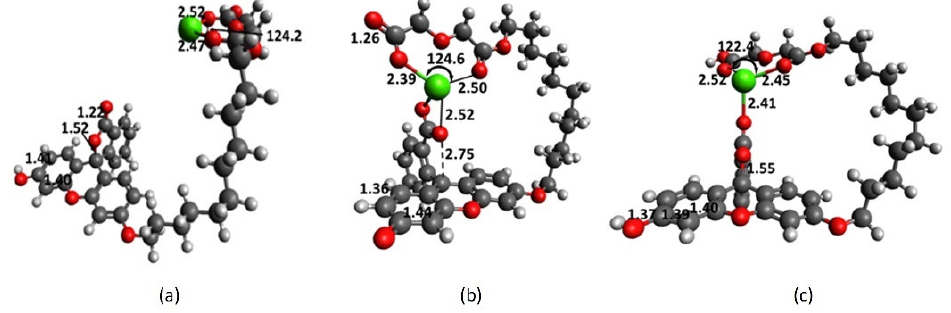
Figure 1. Complexes of 1 and 1a with Ca 2+ in methanol; ( a ) Non-interacting 1 -Ca 2+ , ( b ) strongly interacting 1a -Ca 2+ , and ( c ) interacting 1 -Ca 2+ .